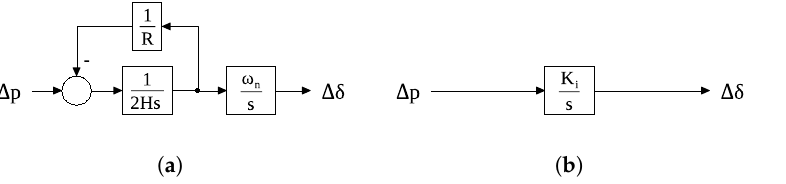
Figure 2. Detail of the angle control block: ( a ) Virtual synchronous machine; ( b ) Power-synchronization